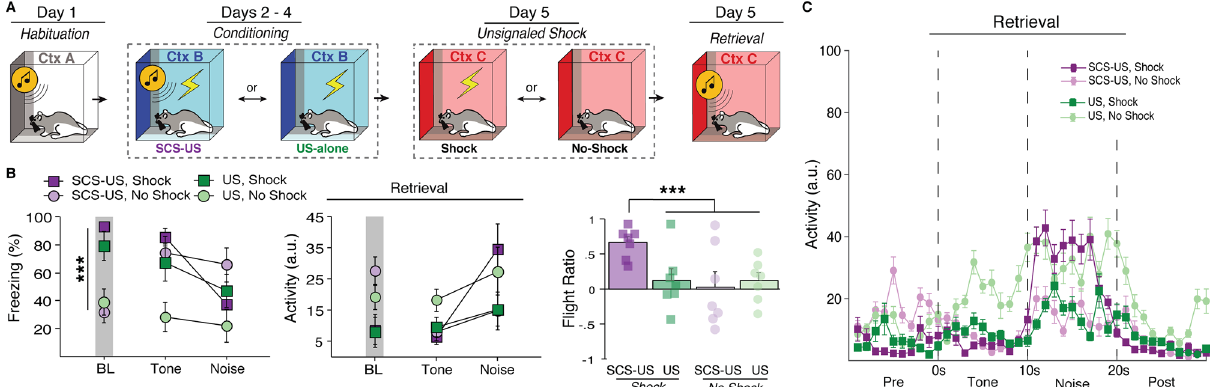
Figure 5. An unconditioned SCS fails to evoke flight behavior in a threatening context. ( A ) Behavioral design. ( B ) Averaged freezing and activity data showing that rats that received US-alone trials throughout conditioning (US) and tested in a US-associated context (Shock) had a reduced flight response in comparison to rats that received SCS-US pairings. This is shown by increased freezing and decreased activity to the white noise stimulus, and a reduced flight ratio. Rats that were tested in a neutral context (No-Shock) also showed reduced flight responses compared to SCS-US/Shock animals. This is further shown by the average activity trace of each group ( C ). All data are represented as mean ± SEM pooled across sex [SCS-US/Shock ( n = 7); SCS-US/No-Shock ( n = 7); US-alone/Shock ( n = 7); US-alone/No-Shock ( n = 7)]; *, **, and *** denote p < 0.05, p < 0.01, and p < 0.001,